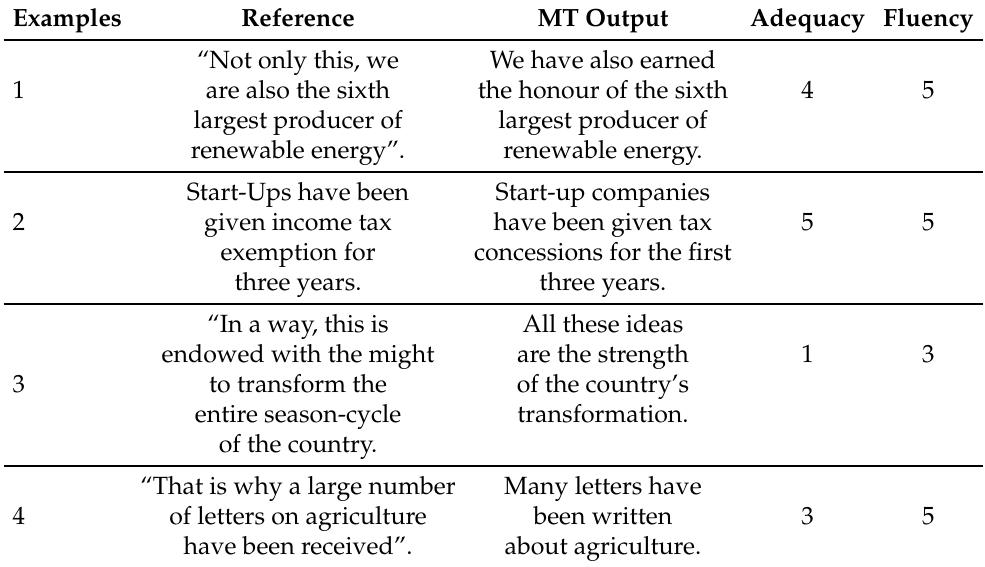
Table 9. Some example Bengali-to-English translation outputs with adequacy and fluency